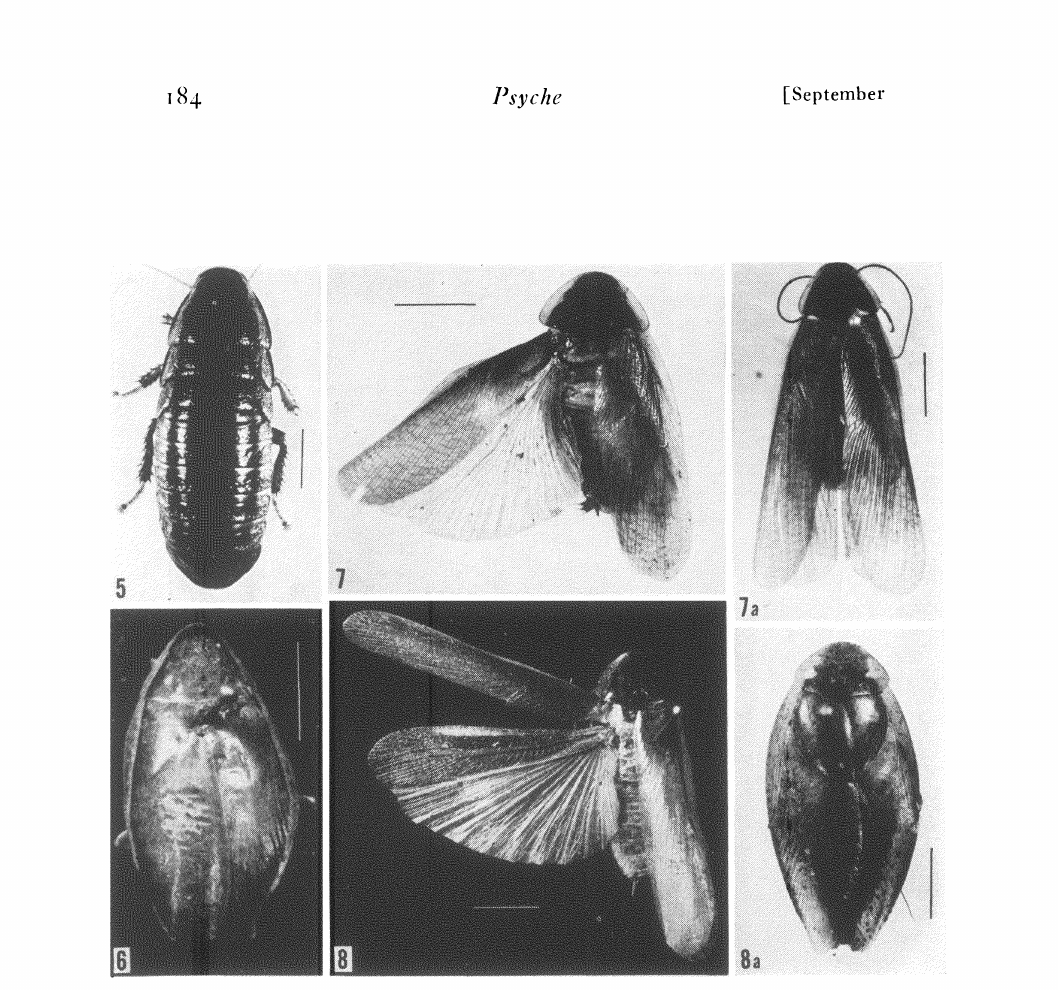
Figs. 5-8a. Adults of Epilamprinae. 5. Poroblattini. Nauclidas nijra (Brunner). (9 adventive obtained from the British museum). 6. (1469L). Notolamprini. Notolampra antillarum Shelford. Trinidad (det. Princis). 7. (119 ANSP). Litopeltis oreas Rehn. Paratype. Santa Maria de Dota Costa Rica. 7a. (172 ANSP). Litopeltis biolleyi (Saussure). Costa Rica (det. Rehn). 8. (114 ANSP). Cariacasia capucina Rehn. Type 1123. Carilla, Costa Rica. 8a. (175 ANSP). Notolampra tl;bba (Thunberg). Pernambuco, Brazil (det. by Hebard as Notolampra cassidea (Burm.), a